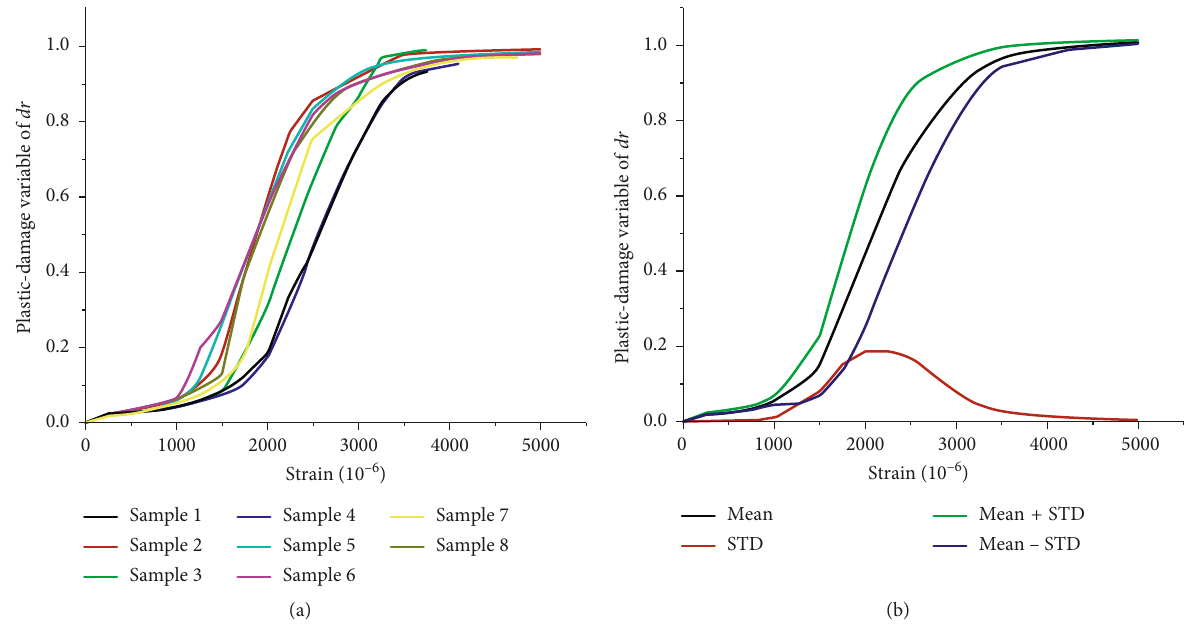
Figure 8: Experimental and predicted (mean and STD) evolution of the plastic-damage variable under compression. (a) Experimental evolution of dr . (b) Predicted evolution on mean and STD of dr .